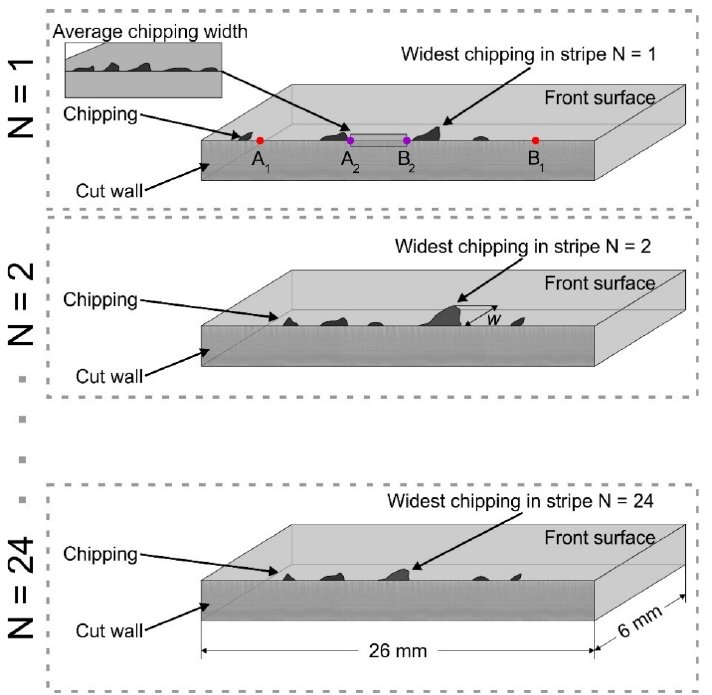
Figure 10. Schematics for evaluating the mean maximum and the average chipping widths at the cut edge. The mean maximum chipping width was evaluated over a distance of 10 mm (between points A 1 and B 1 ). An average chipping width was evaluated over a distance of 1 mm (between points A 2 and B 2 ).